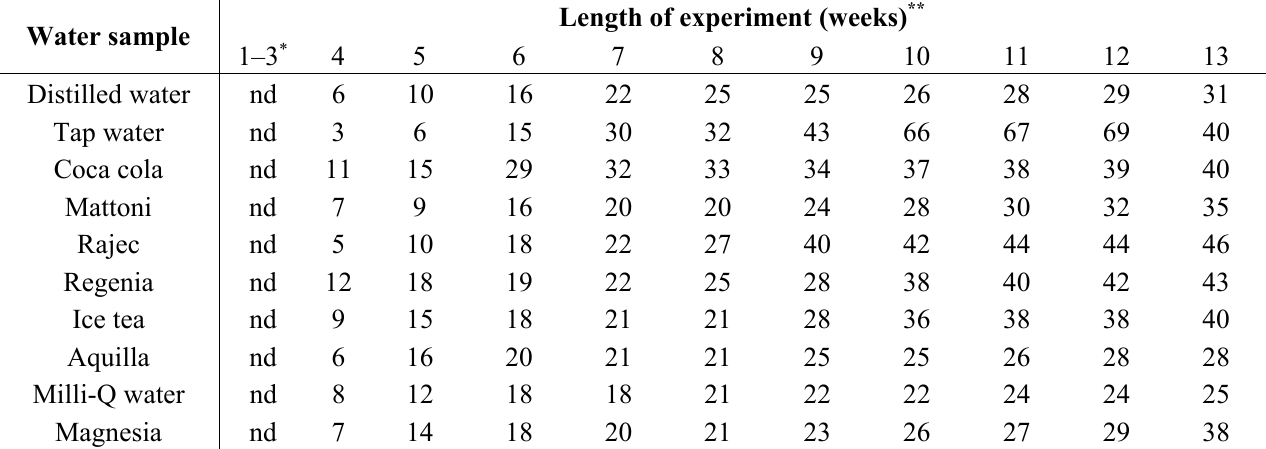
Table 1. Silver(I) ions concentration (nM) determined in waters during 13 weeks long